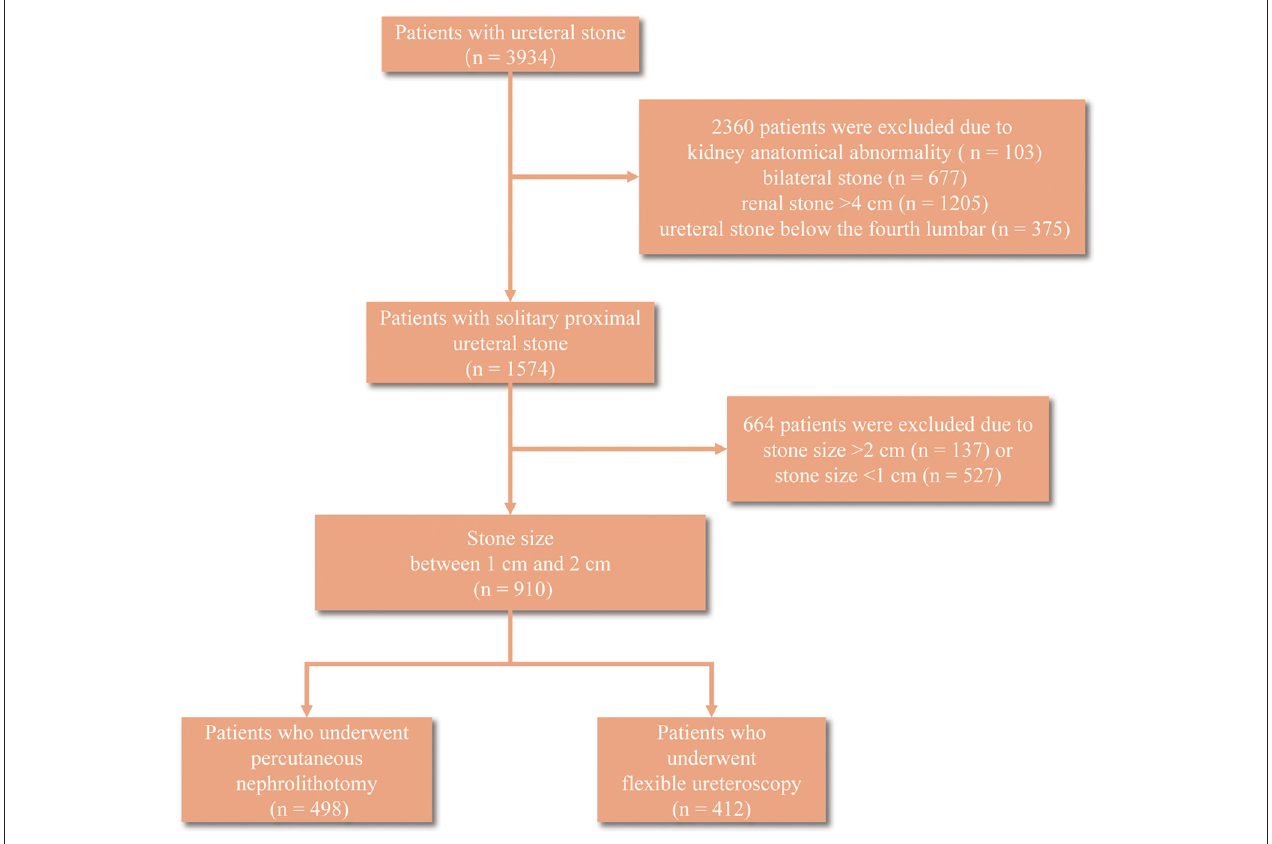
FIGURE 1 | The screening